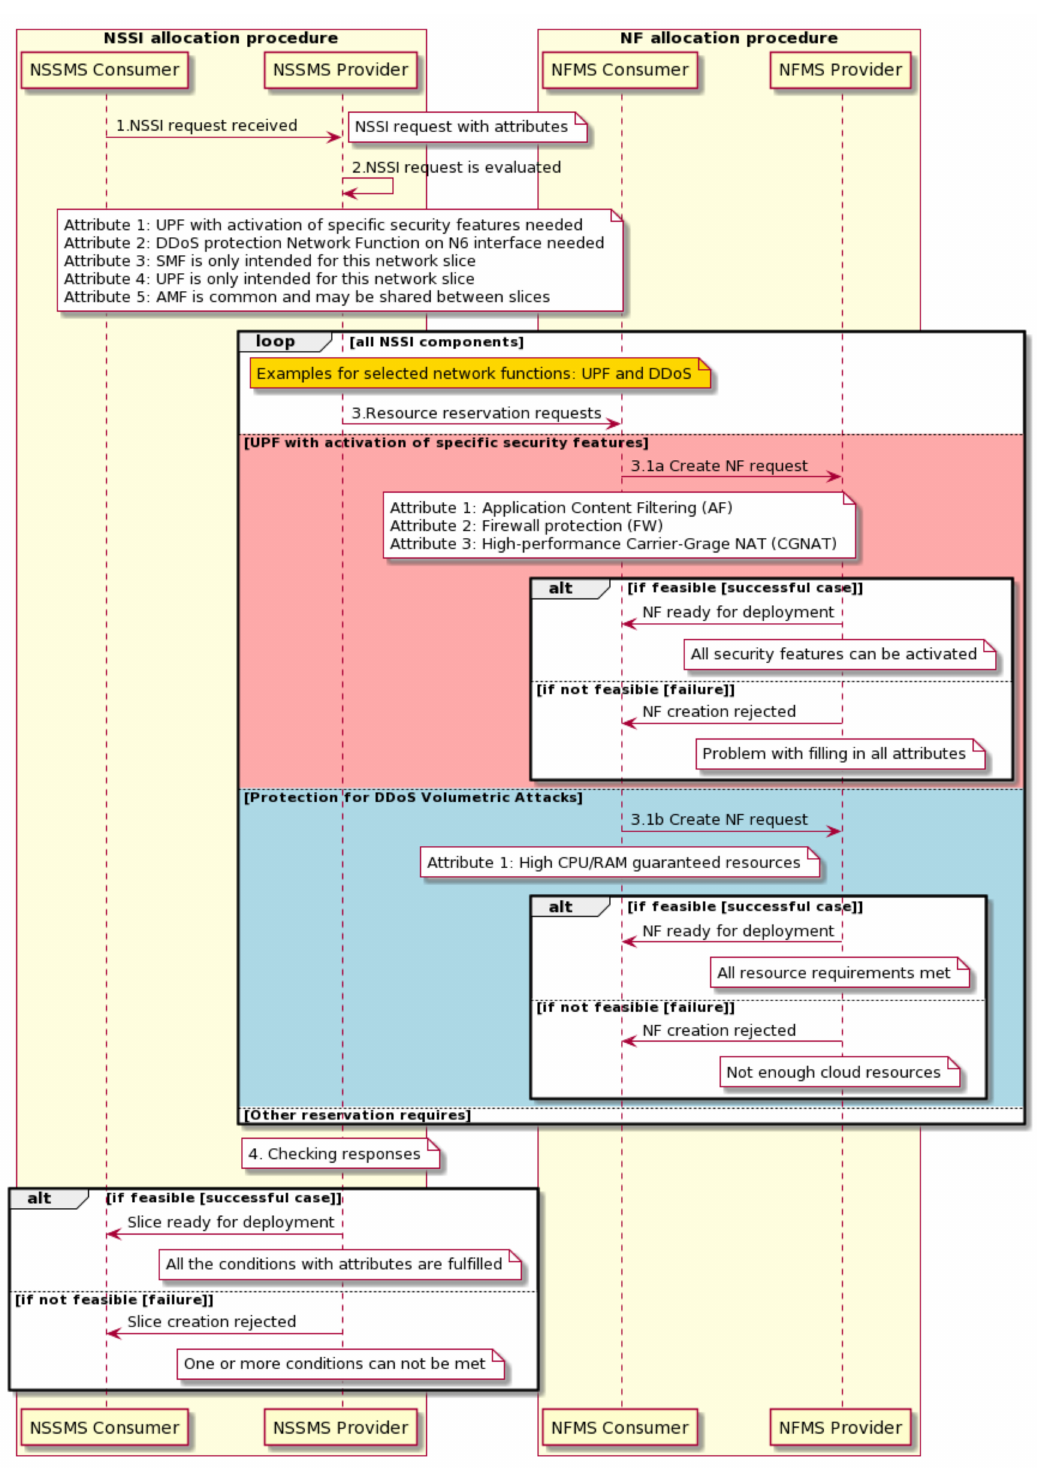
Figure 13. NSSI/NF allocation resources with security